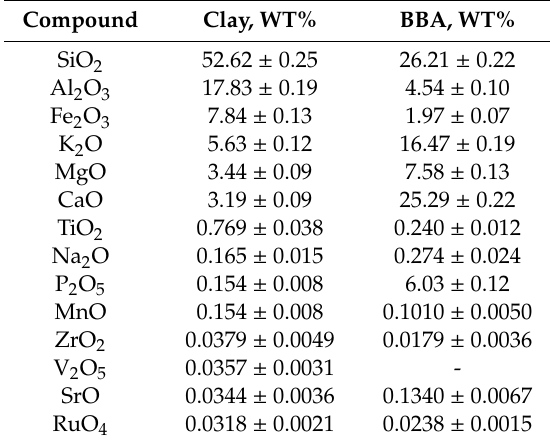
Table 5. X-ray fluorescence of the clay and biomass bottom ash